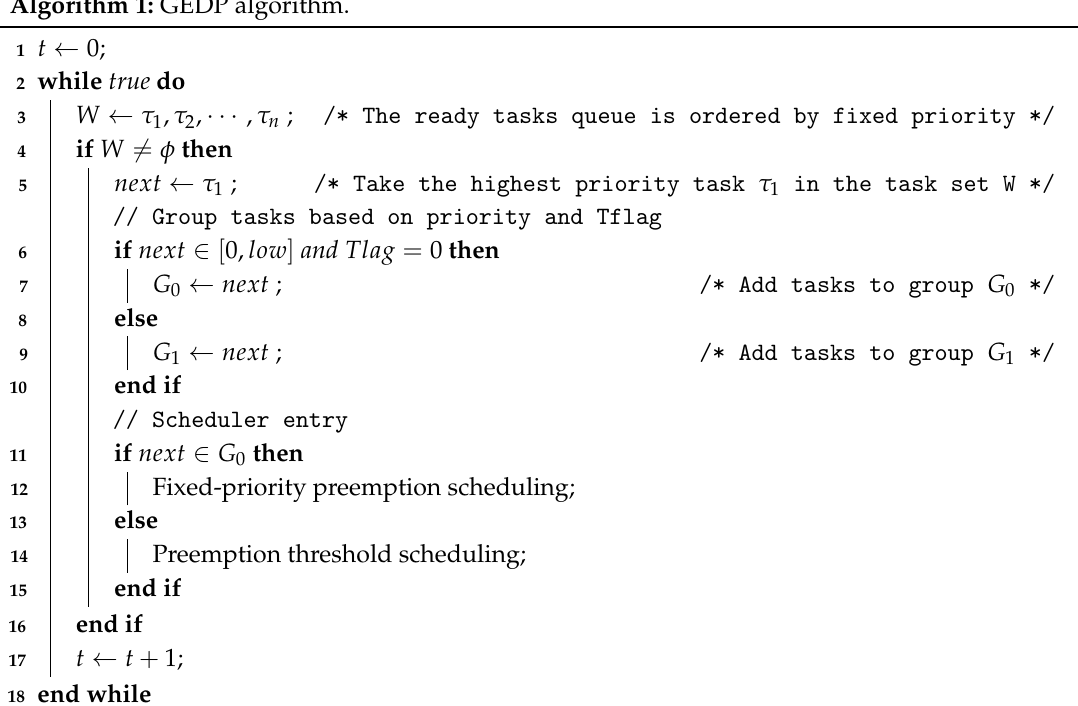
Algorithm 1: GEDP